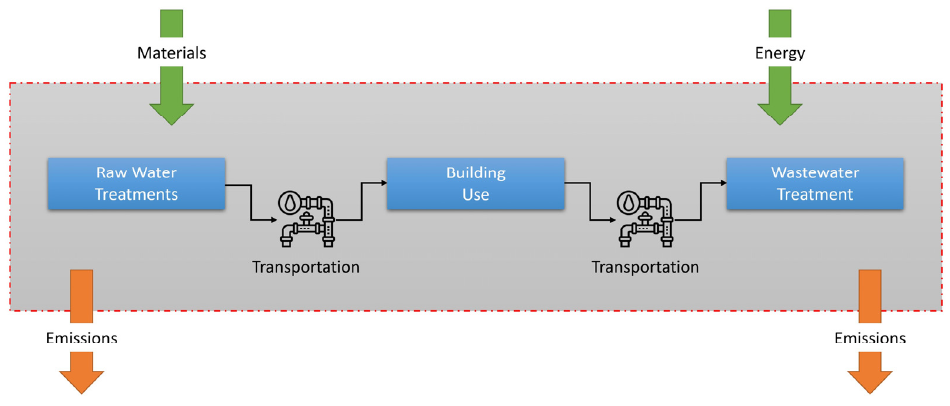
Figure 6. General system boundary for assessment of water-use.